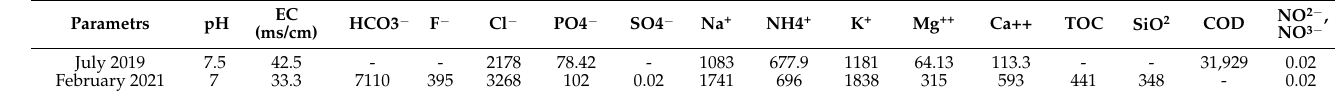
Table 1. Physicochemical characterization of leacheate in Souk Sebt landfill (in summer period, July 2019, and winter period, February 2021).